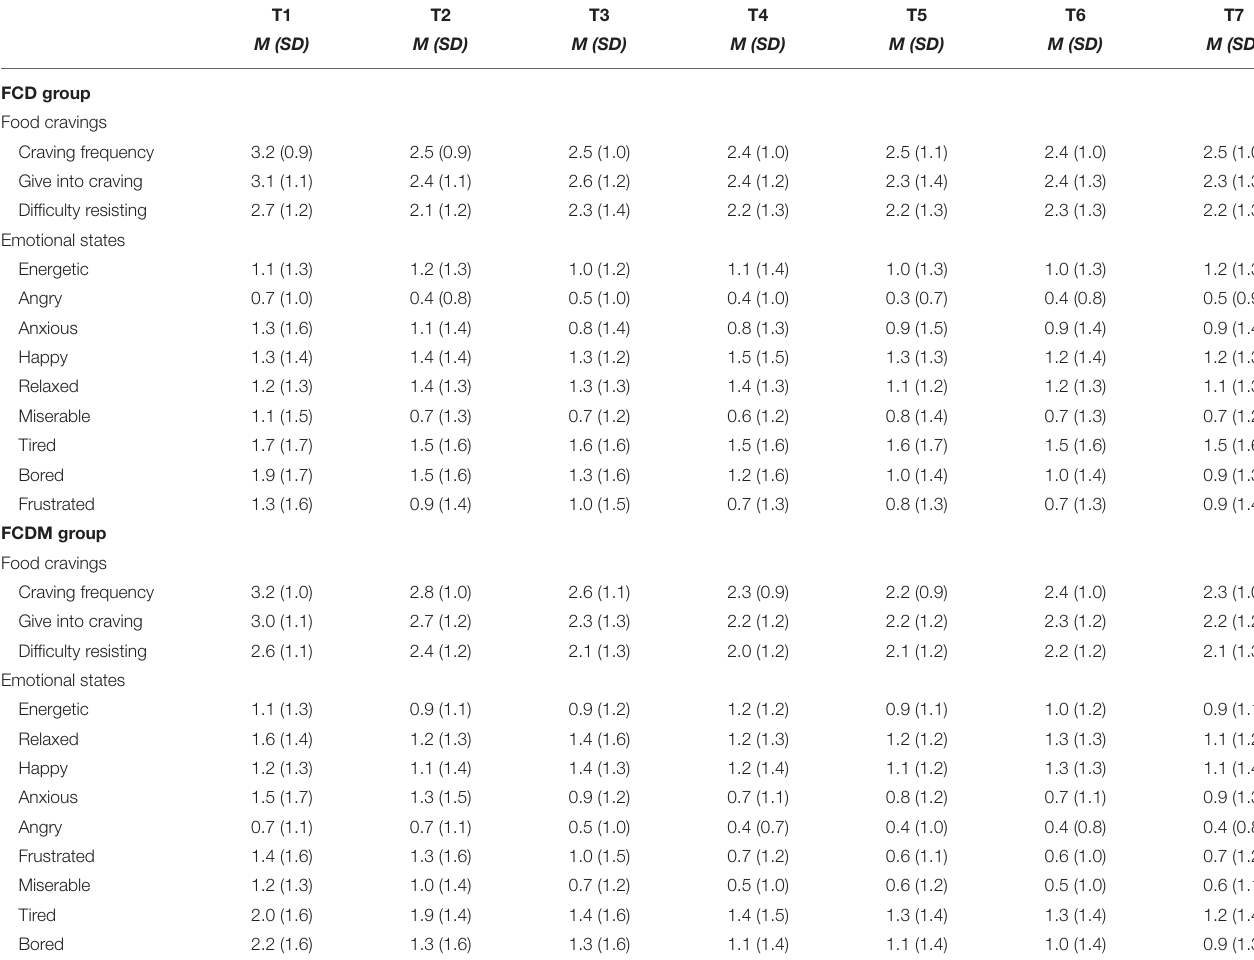
TABLE 1 | Descriptive statistics of food cravings and emotions for participants in FCD group ( n = 88) and FCDM group ( n =